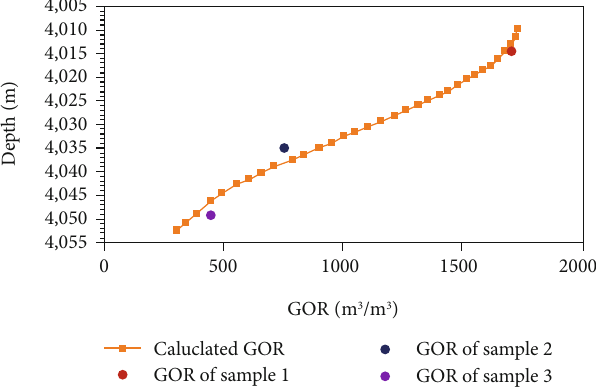
Figure 9: Gas oil ratio of the original fl uid in S condensate